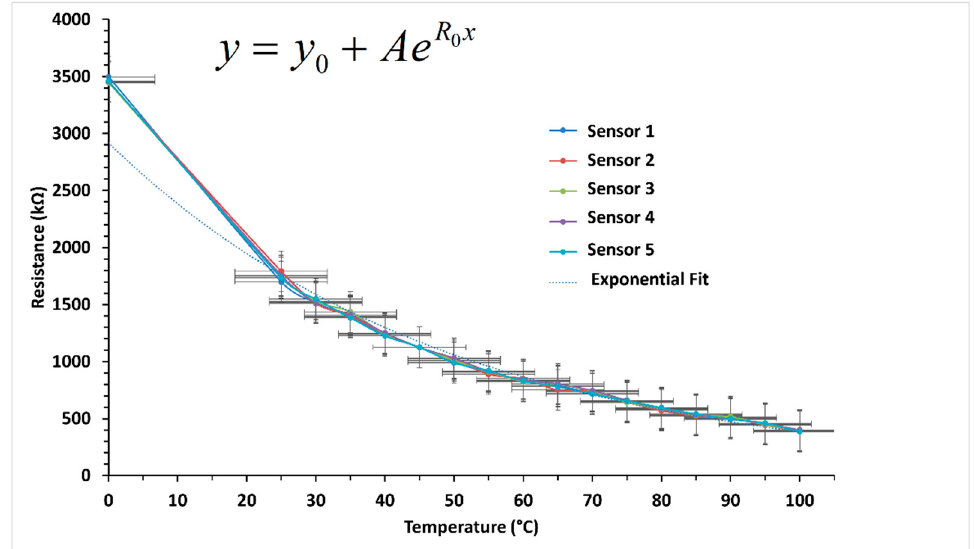
Figure 7. Temperature response of sensors in the form of resistance in k Ω as a function of temperature in °C .